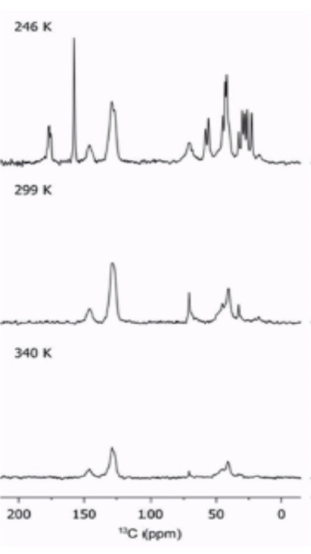
Figure 19. 1 H- 13 C cross polarization NMR spectra of a polystyrene PEG-methylmethacrylate co- polymer at various temperatures (9.4 T, 20 kHz MAS). Magnetochemistry 2018